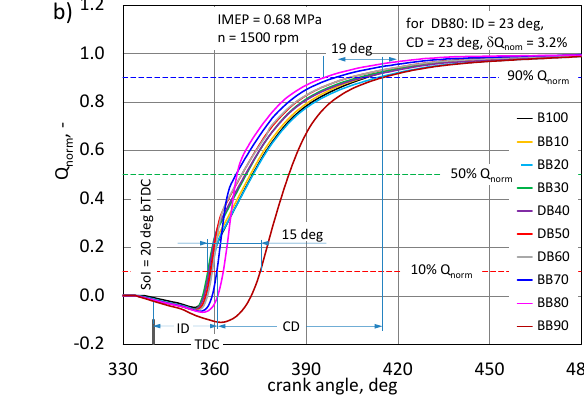
Figure 7. Normalized heat release curves for the DB ( a ) and BB ( b ) powered engine. The curves for the analyzed cases were obtained as the average of 200 consecutive engine operation cycles. Characteristic stages of combustion are marked. From the nature of the Q norm run, it can be seen that the greatest differences for both fuel mixtures will be noticeable for the initial combustion phase. Basic fuels, i.e., diesel fuel and RME biodiesel, differ, inter alia, in the cetane number and thus in their ability to self-ignite [19]. Reciprocating engines powering working machines, especially those powering elec- tricity generators, must meet the requirements for work stability. As reported in the literature [45], the IMEP uniqueness index should not exceed 5%. Figure 8 presents the obtained results of the IMEP uniqueness assessment for the engine powered by DB and BB. For both variants, a set of pressure cycles was also shown, respectively. For the highest obtained COV IMEP values for DB, the maximum COV IMEP value was 4% and for BB as much as 78%.